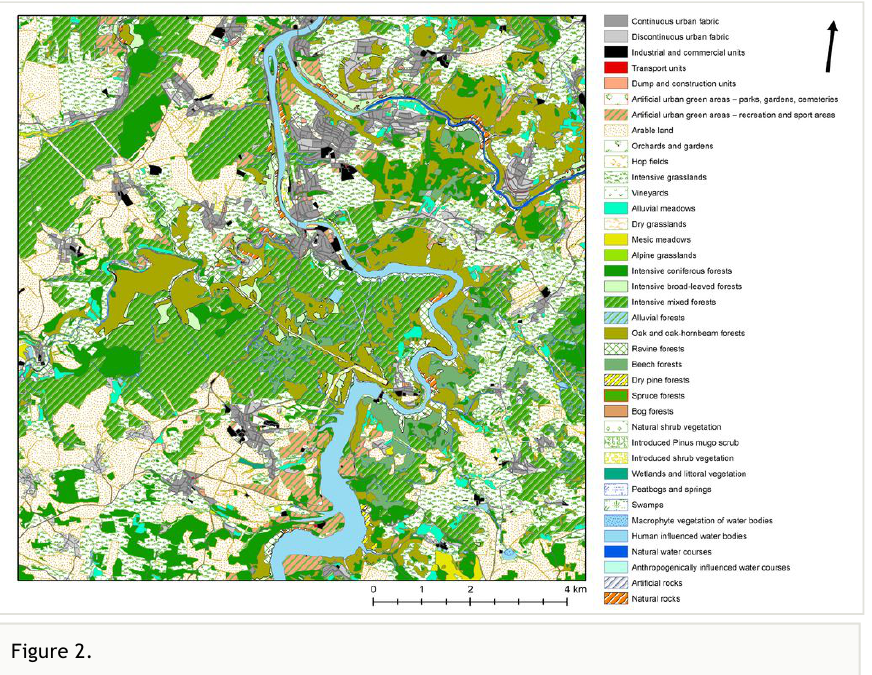
Illustration map of the Consolidated Layer of Ecosystems of the Czech